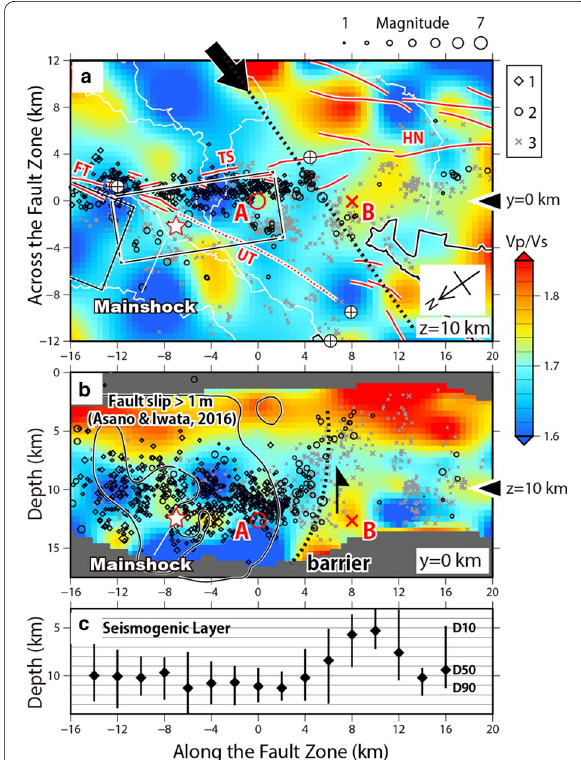
Fig. 7 V p/ V s structure around the southern termination of the 2016 rupture. The symbols for the aftershocks indicate the same occurrence times as those in Fig. 6. a V p/ V s structure at 10 km depth. The solid rectangles represent the surface expression of the source fault planes for the mainshock in Asano and Iwata (2016). The dashed black line and black arrow indicate the southern termination of rupture that was estimated in this study. The solid and dashed red lines denote the active faults determined by RGAF (1991) and HERP (2013), respectively. FT Futagawa segment, UT Uto segment, UN north coast of Uto Peninsula segment, TS Takano–Shirahata segment, HN Hinagu segment. b Vertical section of the Vp/Vs structure along the Hinagu fault zone (y 0 km). The hypocenters located in a range of = y 0–2 km are plotted. The black contour line shows the projected = slip distribution (> 1 m) of the mainshock (Asano and Iwata 2016). The dashed black line and black arrow indicate the southern termination of rupture that was estimated in this study. c Depth ranges of the hypocenters plotted in (b) at a 2-km interval. The top and bottom of each vertical line indicate D10 and D90, respectively, and each diamond indicates D50, where D10, D50, and D90 represent 10, 50, and 90% of the events occurred above those depths in each 2-km